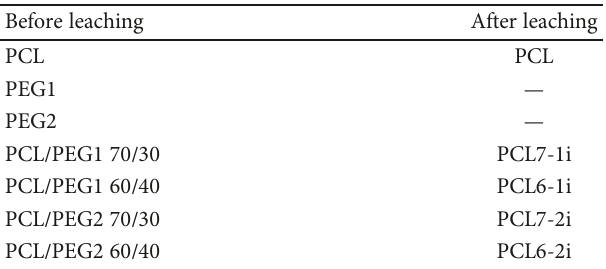
Table 1: Samples nomenclature before and after the PEG leaching